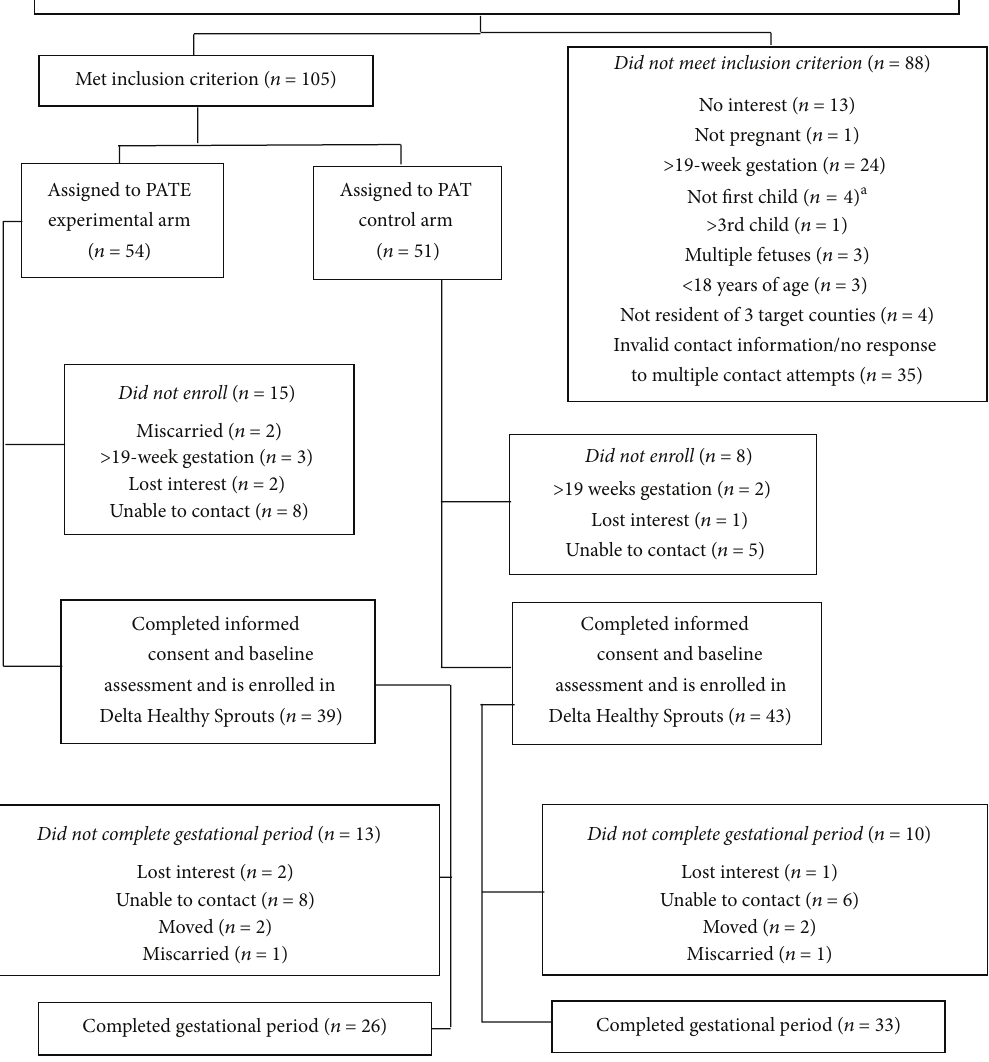
Figure 1: CONSORT diagram of recruitment, assignment, enrollment, and completion of gestational period for Delta Healthy Sprouts. a Original exclusion criterion, later changed to pregnant with > 3rd child. PAT, Parents as Teachers; PATE, Parents as Teachers